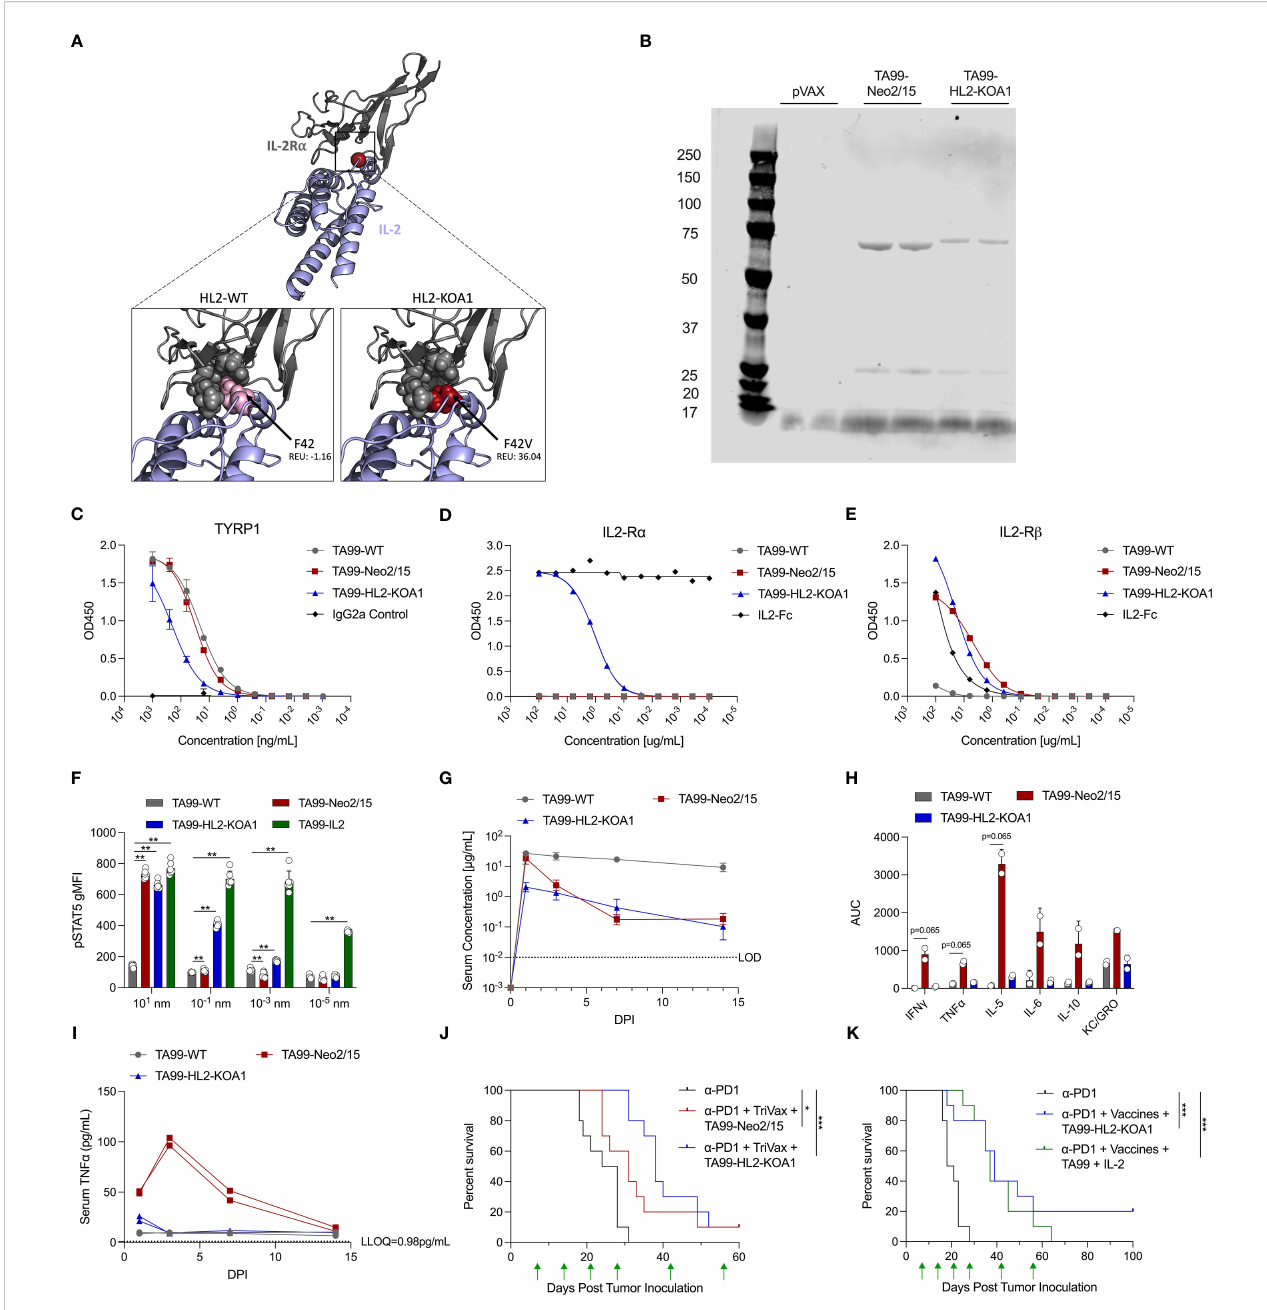
FIGURE 2 Design, pharmacokinetic and pharmacodynamic pro fi les of novel ACC TA99-HL2-KOA1. (A) Model depiction of engineered cytokine mimic HL2-KOA1 binding to IL-2R a . IL-2 shown in blue, IL-2R a shown in grey. Positions in contact with F42 shown as grey spheres. F42 and F42V shown as pink and red spheres respectively. Clash scores provided in total Rosetta energy units (REU). (B) Reducing SDS-PAGE analysis comparing the migration patterns of TA99-WT, TA99-Neo2/15, TA99-HL2-KOA1, pVAX backbone control transfection supernatants. (C) Binding of recombinant TA99-WT, TA99-Neo2/15, and TA99-HL2-KOA1 to recombinant human Tyrp1 compared to a murine isotype IgG2a control. (D) Binding of recombinant TA99-WT, TA99-Neo2/15, and TA99-HL2-KOA1 to recombinant human IL2-R a compared to human IL2-Fc control. (E) Binding of recombinant TA99-WT, TA99-Neo2/15, and TA99-HL2-KOA1 to recombinant human IL2-R b compared to human IL2-Fc control. (F) Geometric mean fl uorescence intensity of phosphorylated STAT5 in CD25+ CD4+ CD19- T cells from naïve mice (n=6) treated with indicated ACC. (G) Pharmacokinetic pro fi le of recombinant TA99-WT and TA99-Neo-2/15 antibodies; C57BL/6 mice were injected intraperitoneally with 100µg of ACC constructs (n=5 mice per group). Serum at the indicated timepoints was assessed for TYRP1 binding by ELISA. (H) Total serum cytokine level over 14-day period in terms of area under the curve (AUC) in mice treated with ACC. (I) Timecourse of serum TNF a levels in sera of mice administered 100µg ACC. Two sera pools were used for (H, I) . (J) Survival curves of mice (n=10 mice per group) post tumor challenge following treatment with anti-PD1 alone, or anti-PD1 (200µg) + TA99-Neo2/15 (50µg) + TriVax (10µg each of Trp2, Gp100 and Tyrp1), or anti-PD1 (200µg) + TA99-HL2-KOA1 (50µg) + TriVax. 1x10 5 B16F10 cells subcutaneously into the right fl ank of C57BL/6 mice on Day 0. Green arrows indicate administration of treatment. (K) Survival curves of mice (n=10 mice per group) post tumor challenge following treatment with anti-PD1 alone, or anti-PD1 (200µg) + TA99-HL2-KOA1 (50µg) + TriVax, or anti-PD1 + TA99 (50µg) + Human IL2 (5µg) + TriVax. Challenge and treatment scheme was performed as in (J) Error bars represent standard deviation; non-parametric Mann Whitney T test compared with TA99-WT used in (F) ; non-parametric Kruskal-Wallis ANOVA was used in (I) ; log-rank test was used to compare between differences in all survival curves; *p<0.05, **p<0.01,